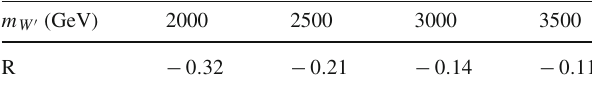
Table 6 The numerical results for the relative corrections of W (cid:2) pre- dicted by the UU model to the decays B − → γ l − ¯ ν l ( l = e ,μ,τ) and D + → γ l + ν l ( l = e ,μ) , in unit of 10 − 2 m W (cid:2) ( GeV